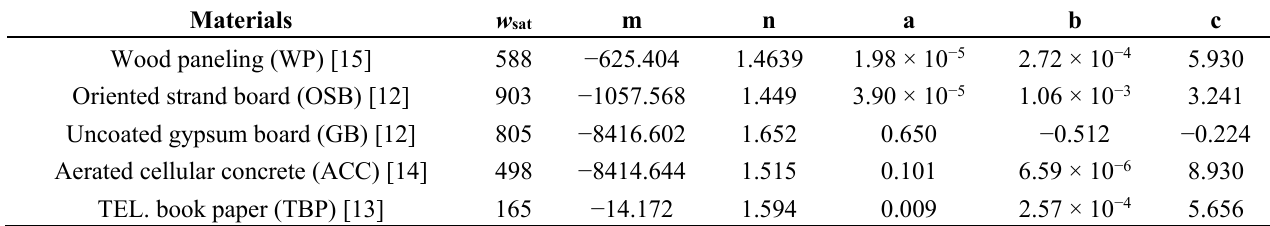
Table 3. Constants used for sorption isotherm curve and vapor transfer resistance factor of materials used in this paper.